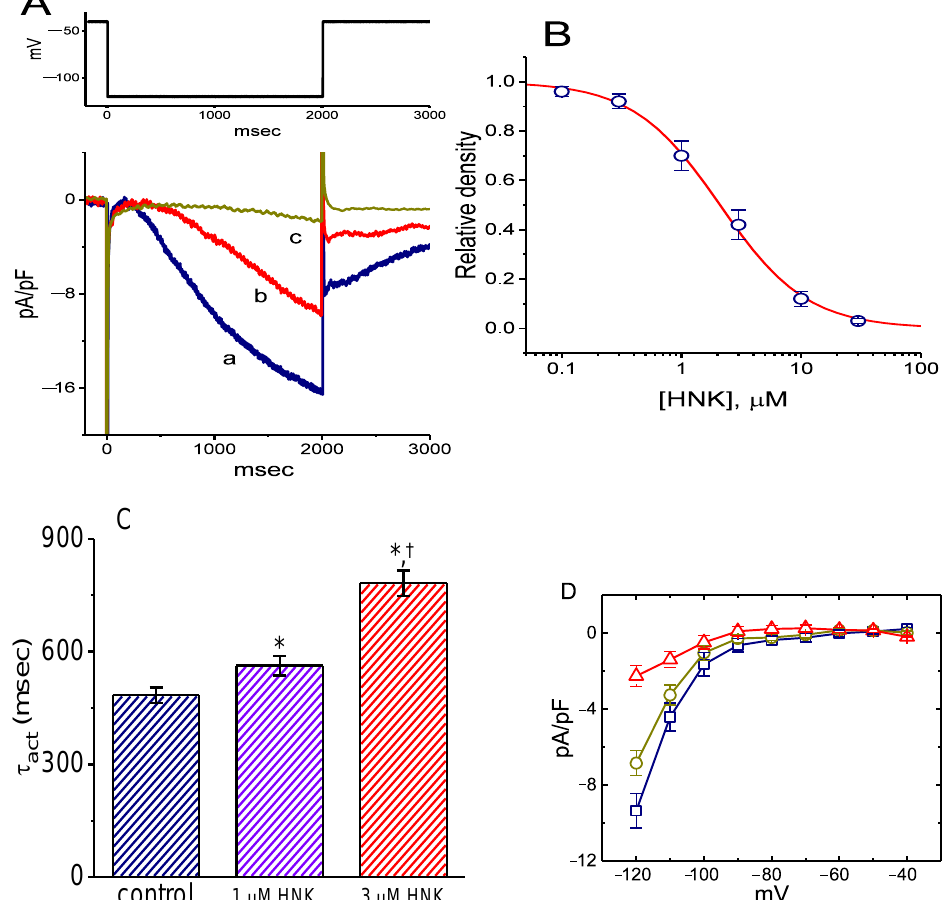
Figure 1. Concentration-dependent inhibition of hyperpolarization-activated cation current ( I h ) by honokiol (HNK) in GH 3 cells. ( A ) Representative I h densities obtained in the absence and presence of HNK. In these experiments, we bathed cells in Ca 2+ -free Tyrode’s solution containing 1 μM tetrodotoxin, the recording electrode was filled with a K + -containing solution, and the hyperpolarizing pulses from −40 to −120 mV were applied with a duration of 2 s. Current density labeled a is the control, and that labeled b or c was obtained after the addition of 3 μM HNK or 10 μM HNK, respectively. The upper part denotes the voltage clamp protocol applied. ( B ) Concentration–response relationship for HNK-induced inhibition of I h density (mean ± standard error of the mean (SEM); n = 8 for each data point). The sigmoidal curve represents best fit to the modified Hill equation, and effective half-maximal concentration (IC 50 ) value was calculated to be 2.1 μM. ( C ) Summary bar graph showing the effect of HNK on the activation time constant (τ act ) of I h density (mean ± SEM; n = 7 for each bar). Current density was obtained by 2-s hyperpolarizing cells to −120 mV from a holding potential of −40 mV. * Significantly different from control ( p < 0.05) and † significant different from HNK (1 μM) alone group ( p < 0.05). ( D ) Mean current density versus voltage relationships of I h obtained in the control ( □ ), during exposure to 10 μM HNK ( △ ), and after washout of the compound ( ○ ) (mean ± SEM; n = 7 for each data point). Current densities were obtained at the end of the 2-s hyperpolarizing steps from a holding potential of −40 mV. The relationship between the HNK concentration and the relative density of I h is illustrated in Figure 1B. The presence of HNK was found to depress the density of I h during long membrane hyperpolarization in a concentration-dependent manner. From the analysis of the modified Hill equation, the half-maximal concentration required for inhibitory effect of HNK on the density of hyperpolarization-induced I h was estimated to be 2.1 μM; and, HNK at a concentration of 30 μM almost fully decreased current density. The mean current density-voltage relationships for I h taken with or without the addition of HNK (3 μM) displaying non-ohmic behavior were established and are plotted in Figure 1D. As cells were exposed to HNK, the I h densities biophysically characterized by an inwardly rectifying property, were depressed throughout the entire voltage clamp step applied. For example, HNK (3 μM) decreased whole-cell conductance of I h linearly measured at the voltages between −120 and −100 mV from 0.38 ± 0.03 to 0.09 ± 0.01 nS/pF ( n = 7, p < 0.05); moreover, washout of the compound, the I h conductance was returned to 0.30 ± 0.02 nS/pF ( n = 7, p < 0.05). 2.2. Modification of the Steady-State Activation Curve of I h Produced by the Presence of HNK To characterize the inhibitory effect of HNK on I h density in GH 3 cells, we further wanted to determine its possible modifications on the steady-state activation curve of I h density. Figure 2 illustrates the voltage-dependent activation curve of I h density collected with or without the HNK (10 μM) addition. In this set of experiments, we designed and then applied a two-step voltage pulse